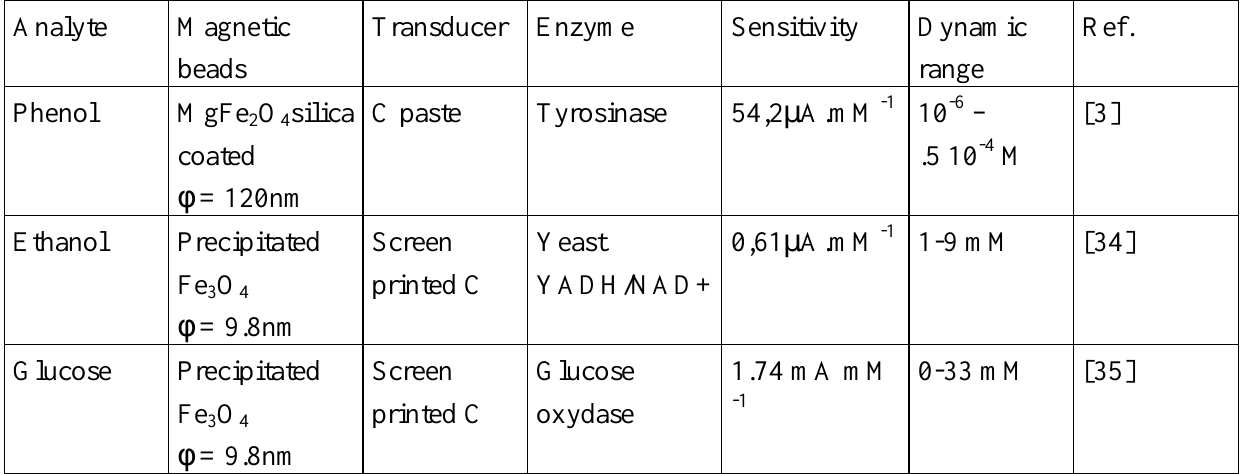
Table 4. Examples of magnetic microbeads based enzymatic biosensors.